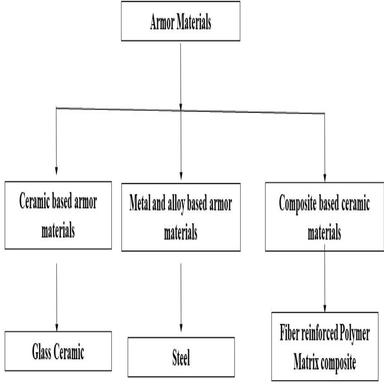
Classification of armor materials.